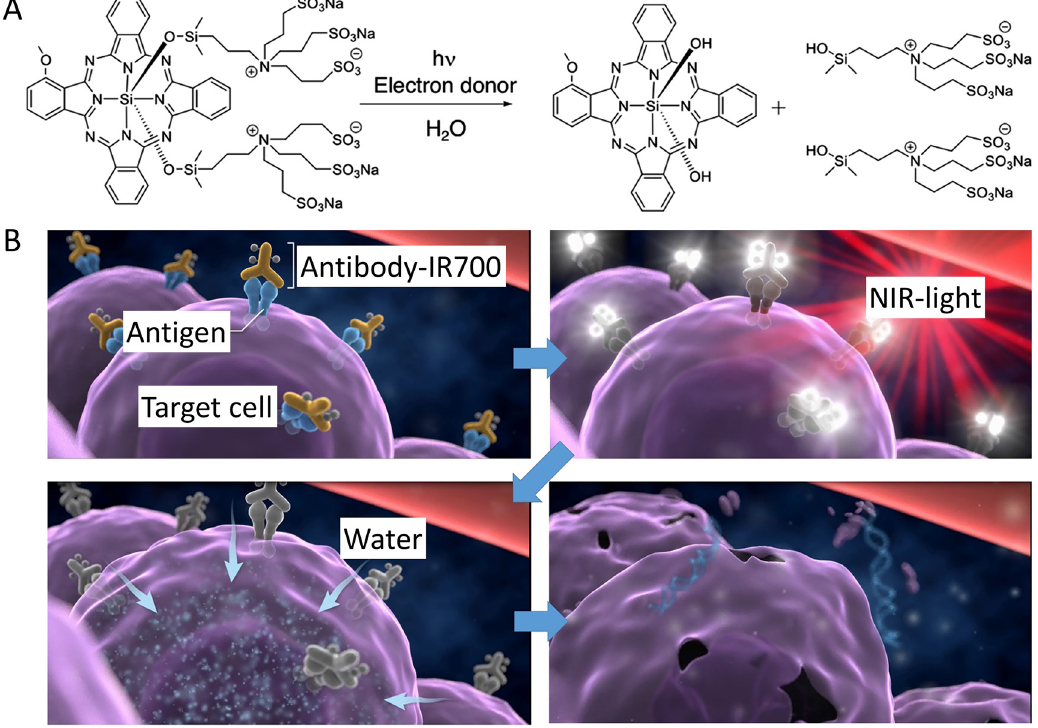
Figure 1: The mechanisms of cell death caused by